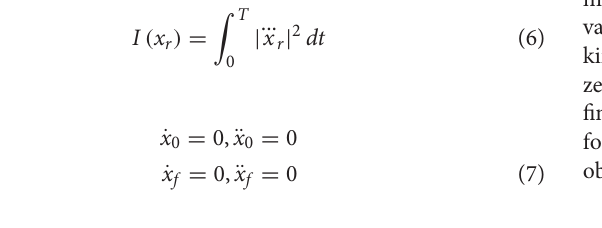
was obtained through the MJ model, with initial constant values ( y , z 0 ) in the other motion axes, i.e., the Y and Z 0